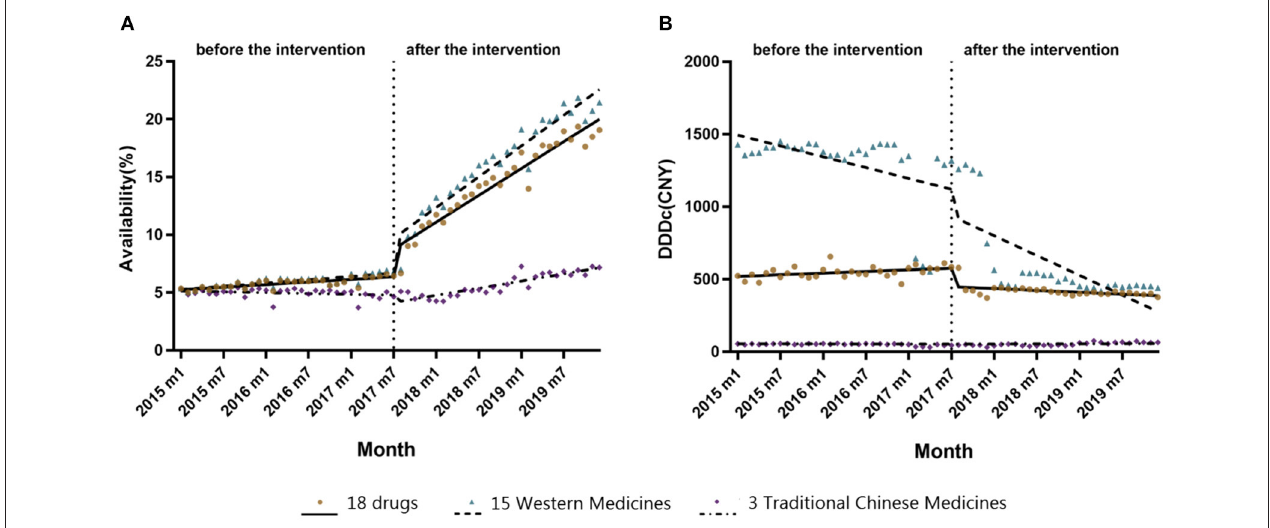
FIGURE 3 | (A) Changes in monthly availability (%) of the 15 Western Medicines, 3 Traditional Chinese Medicines, and all 18 drugs combined both before and after NRDLN implementation in July 2017. (B) Changes in monthly DDDc (CNY) of the 15 Western Medicines, 3 Traditional Chinese Medicines, and all 18 drugs combined both before and after NRDLN implementation in July